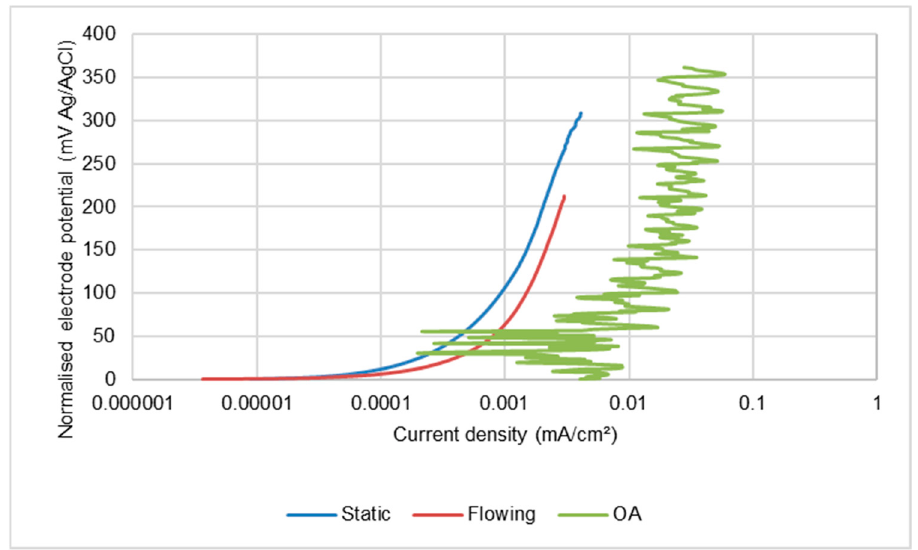
Figure 15. Comparison of anodic polarisation behaviour in 0.05% NaCl of UNS S31600 alloy in outer zone of SLEC specimen with those in static and LEC conditions.